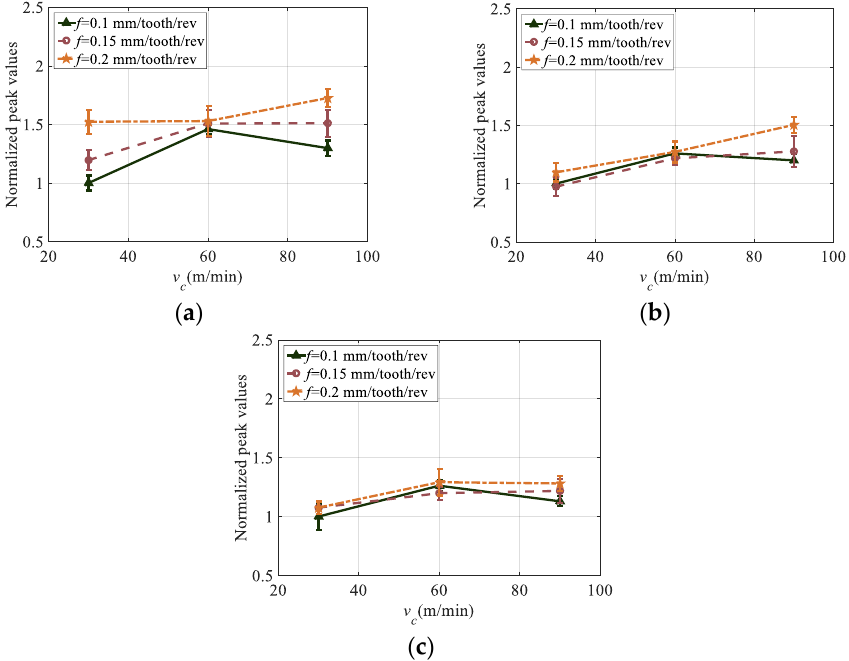
Figure 7. The influence of cutting speed on milling forces: ( a ) Case 1 (milling in XY plane), ( b ) Case 2 (milling in XZ plane), ( c ) Case 3 (milling in YZ plane) for the workpiece built with SSR of 67°.